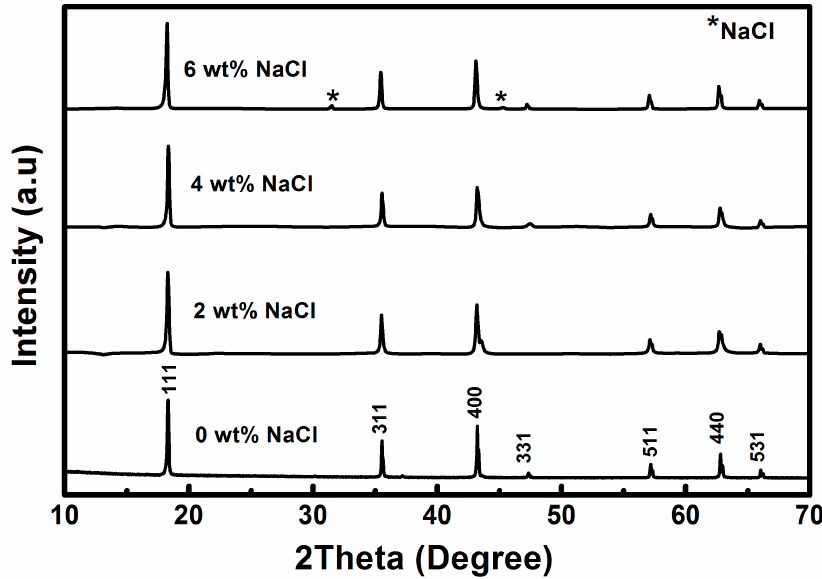
Figure 1. The XRD patterns of Li 4 Ti 5 O 12 (LTO) powder in various NaCl additions.